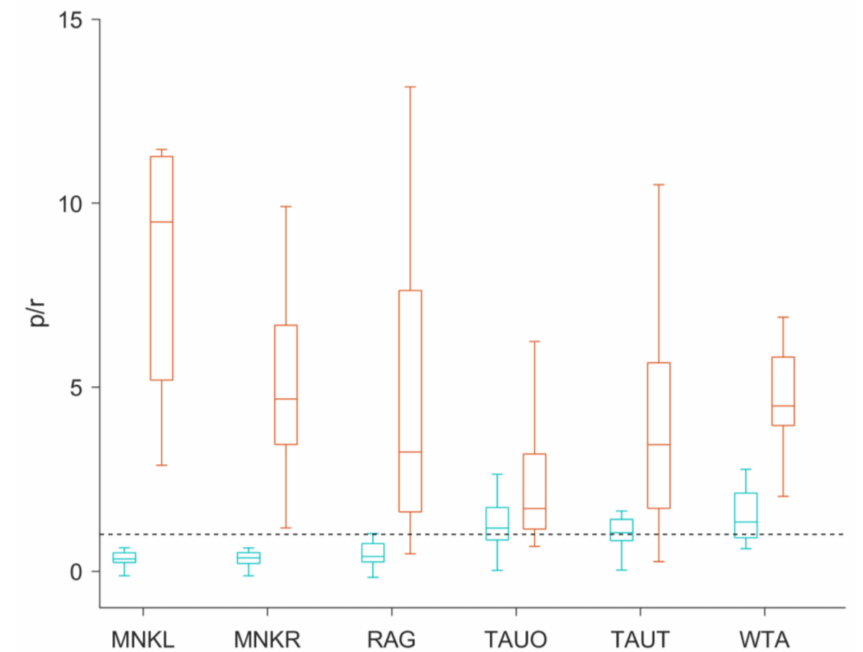
Figure 6. Photosynthesis / respiration ratio (p / r) during submerged (blue) and emerged (red) tidal periods with data pooled across all sampling dates and treatments. Boxes are the 25th and 75th percentiles, and whiskers the 5th and 95th percentiles. The dotted line is provided as a reference to p / r = 1. Table6. Distance-basedLinearModel(DistLM)resultsforsubmergedandemergedprimaryproductions measures. Marginal tests provide the proportion of variation explained when considered individually. Full model shows the variables included in the stepwise DistLM and the variance attributed to each. Partitioning of variance shows the variance explained solely by environment, community and porewater predictors, and in parentheses, the variance shared by two or more predictor groups.